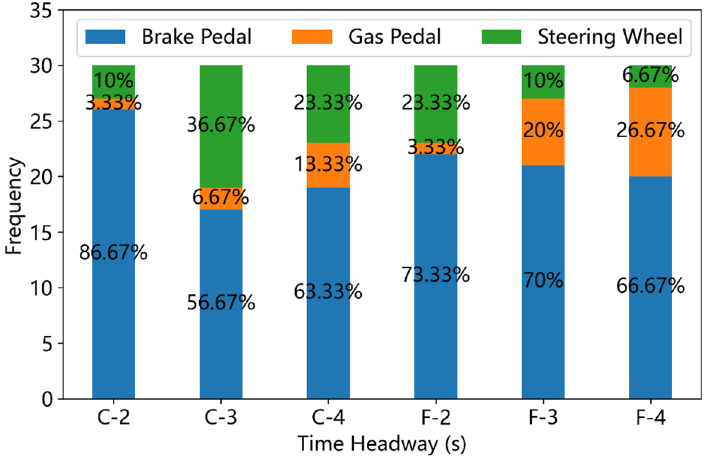
Figure 8. Frequency of different takeover responses under sub-critical (ALV = − 2 m/s 2 ) driving scenarios (C means ‘clear weather’ and F denotes ‘fog condition’).